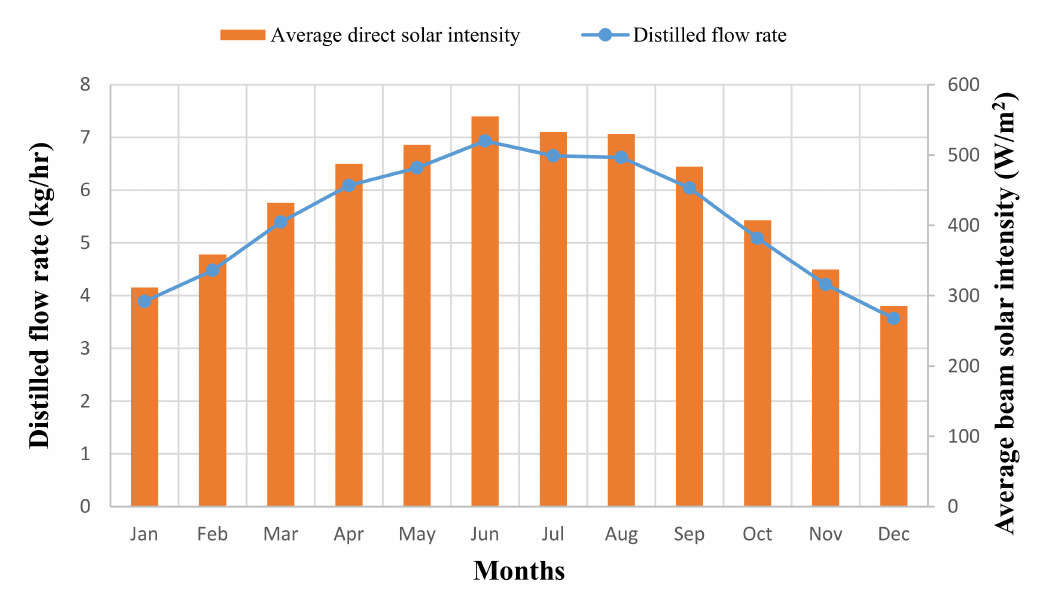
Figure 10. Improved system distilled flow rate variation with respect to average beam solar